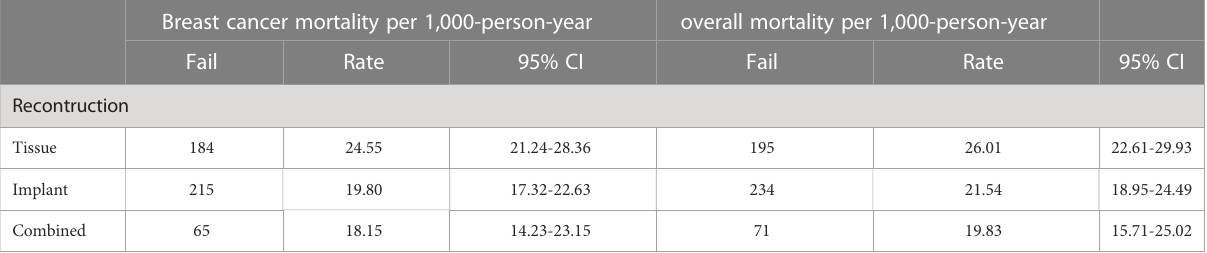
TABLE 3 Comparison of breast cancer and overall mortality per 1,000-person-year between different reconstruction types.